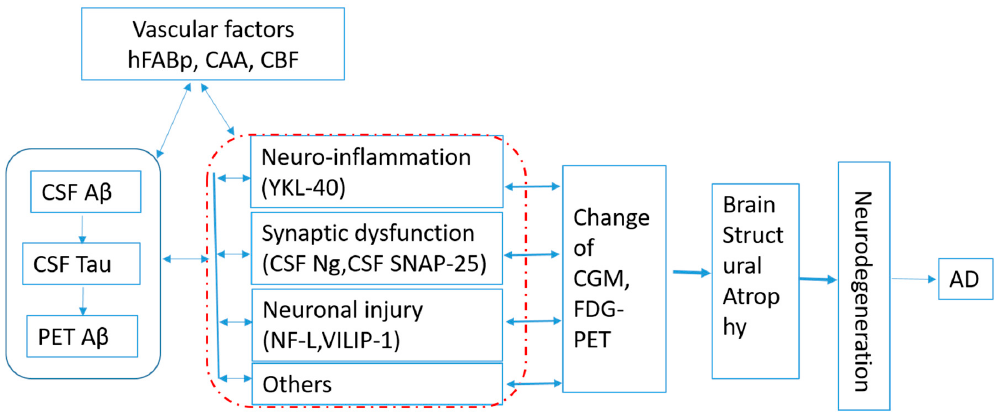
Figure 1. Hypothesis of Alzheimer’s disease (AD) pathogenesis. HFABp: heart-type fatty acid binding protein, CAA: cerebral amyloid angiopathy, CBF: cerebral blood flow, CGM: cerebral glucose metabolism, FDG-PET: 18F-positron emission tomography-computed tomography, CSF A β : cerebral spinal fluid beta amyloid, CSF Tau: cerebral spinal fluid Tau protein, PET-A β : Amyloid-beta assessed by florbetapir PET. Ng: neurogranin; SNAP-25: synaptosomal-associated protein 25; YKL-40: chitinase-3-like protein 1; NFL: neurofilament light chain; VILIP-1:visinin-like protein